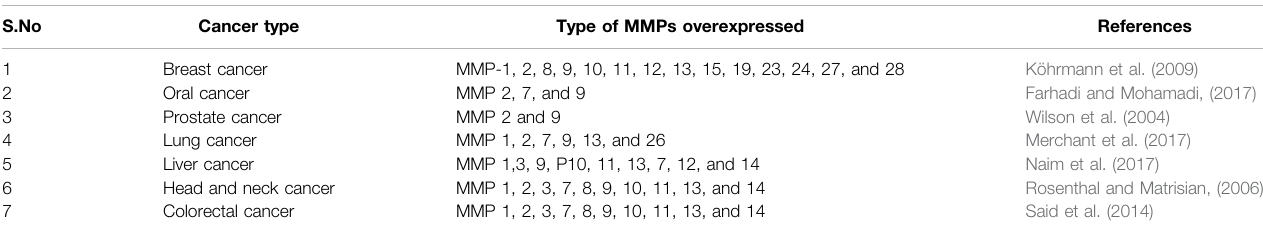
TABLE 2 | Type of MMPs involved in various